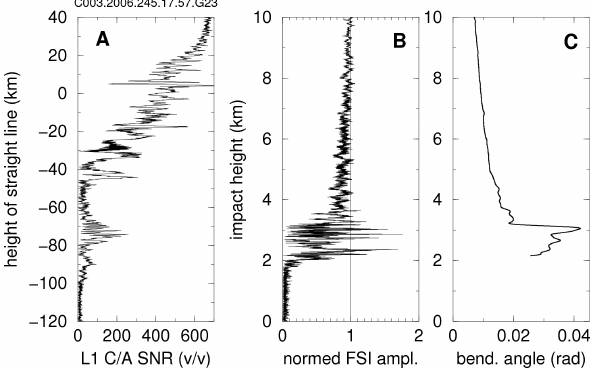
Fig. 3. Panel A : amplitude of raw RO signal (as function of straight- line height); panels B and C : amplitude and bending angle as func- tions of impact height derived from the FSI-transformed